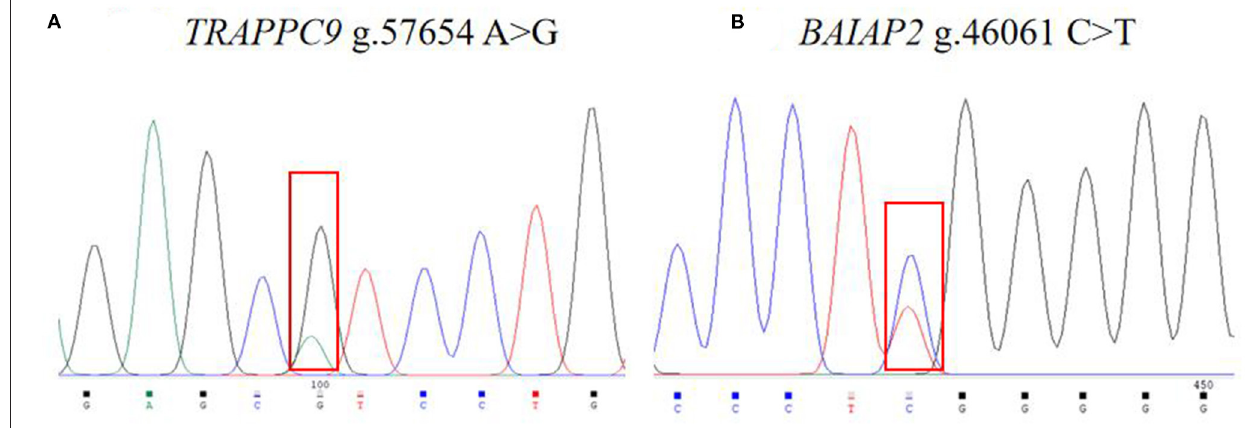
FIGURE 2 | Image of the sequencing peaks of sheep TRAPPC9 (A) and BAIAP2 (B) loci.